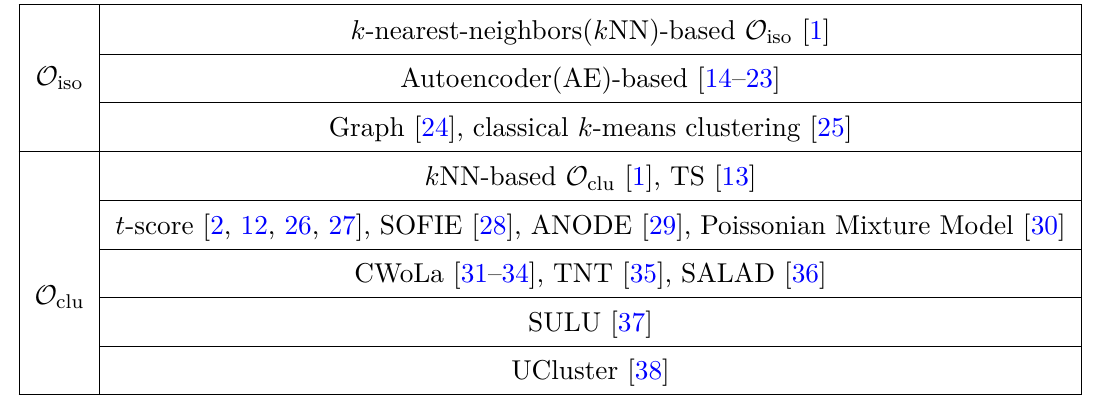
Table 1 . A short summary of the isolation-based and clustering-based novelty evaluators/algorithms.